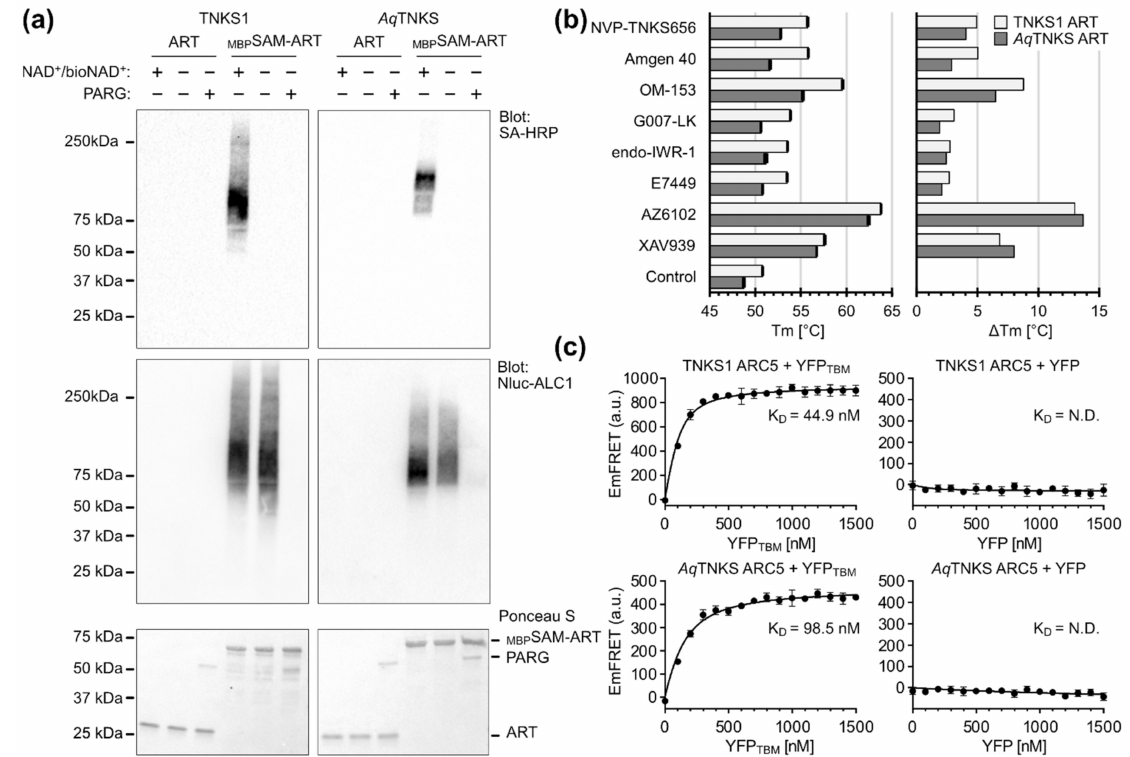
Figure 5. Experimental validation of the tankyrase molecular functions from Amphimedon queens- landica . ( a ) Western blot of ART and SAM-ART constructs from human TNKS1 and A. queenslandica TNKS ( Aq TNKS). SAM-ART constructs contain an N-terminal maltose-binding protein (MBP) tag. TNKS constructs (2 µ M) were incubated for 1 h at room temperature in presence or absence of a mixture containing biotin-NAD + /NAD + (1:10). The total NAD + concentration was 2 µ M for TNKS1 and 10 µ M for Aq TNKS due to a lower activity observed in Aq TNKS. PAR with incorporated biotin was detected with streptavidin conjugated to horseradish peroxidase (SA-HRP), while total PAR modification independent of biotin was detected using nanoluciferase fused to ALC1 (Nluc-ALC1). PARG (0.2 mg/mL) was added to verify a removal of PAR chains. ( b ) Thermal stabilization of TNKS ART domain constructs by selective TNKS inhibitors. Differential scanning fluorimetry (DSF) was performed after mixing TNKS ART domain constructs (5 µ M) and TNKS inhibitors (25 µ M). A control without inhibitor was included. The absolute melting temperatures (Tm) are shown on the left and data shown are mean ± standard deviation with number of replicates n = 4; the melting temperature relative to the respective controls calculated from the mean values are shown on the right. ( c ) FRET-based determination of the dissociation constant K D for ARC5 constructs with a TBM peptide. CFP-fused ARC5 constructs (100 nM) from TNKS1 or Aq TNKS were mixed with different concentrations of YFP fused to the TBM peptide (REAGDGEE). As control, the CFP-ARC5 constructs were mixed with YFP without the TBM peptide. The fluorescence emissions from FRET (EmFRET) were determined by a method described by Song et al. [51]. Data shown are mean ± standard deviation with number of replicates n =